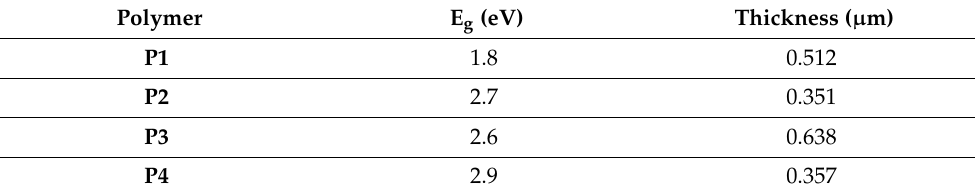
Table 2. Optical band gap data of for polymer films estimated by the Tauc